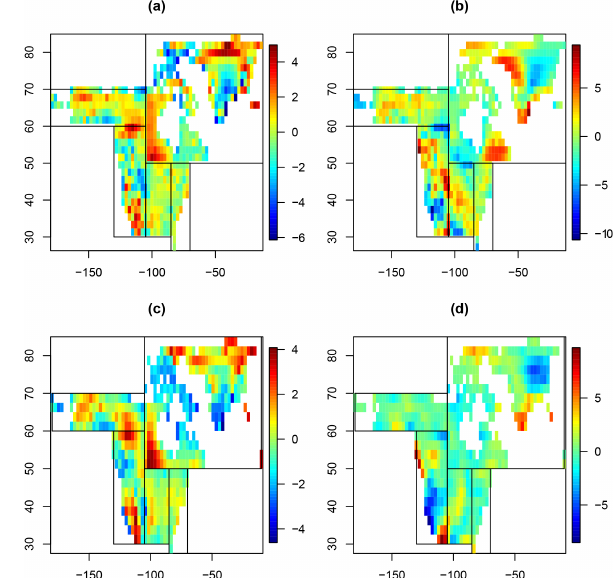
Figure 6. North America and Greenland JJA residuals: GFDL for (a) temperature and (b) 1000 (precipitation) 1 / 3 , and from NCEP/GPCP for (c) temperature and (d) 1000 (precipitation) 1 / 3 .